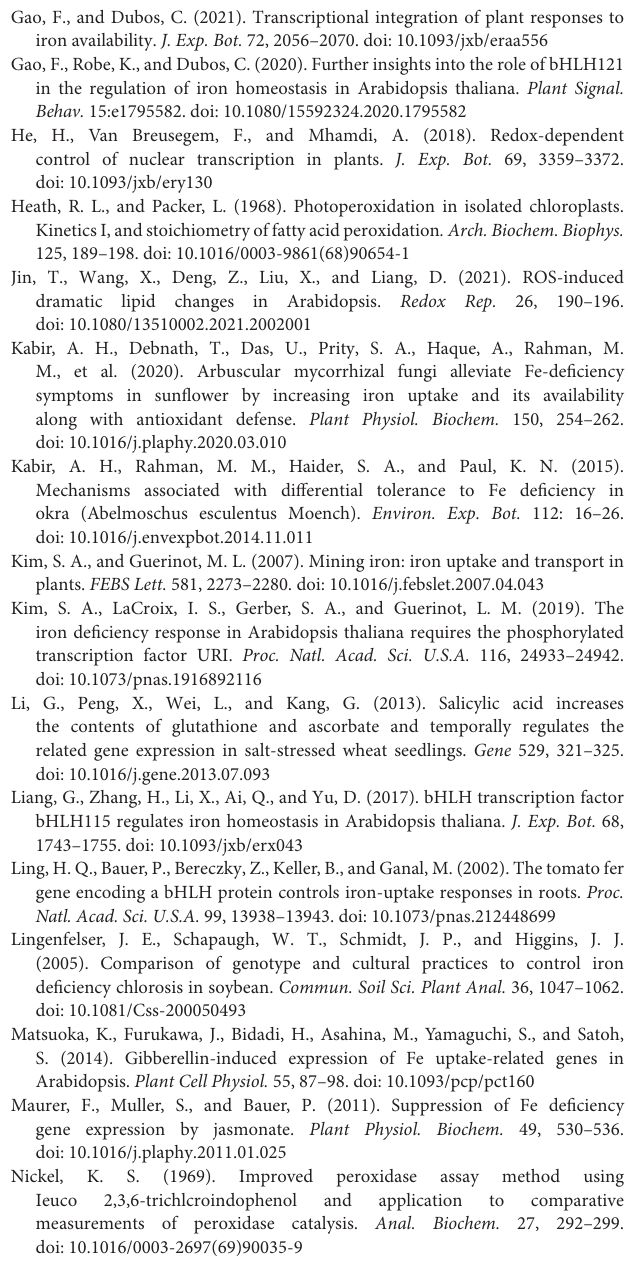
KEGG analysis between -Fe and E-Fe. E = P. liquidambaris inoculation. -Fe = 2 µ mol FeEDTA in Hogland nutrition. CK = 100 µ mol FeEDTA in Hogland nutrition. Supplementary Figure 8 | The qRT-PCR analysis of genes in the roots under Fe-sufficient or Fe-deficient conditions after P. liquidambaris colonization. The relative expression of each gene was calculated as the 2 − 11 CT value and normalized to the endogenous reference genes. Data and errors are mean ± SD, n = 6, and different letters indicate significant differences among treatments. p < 0.05. -Fe = 2 µ mol FeEDTA in Hogland nutrition. CK = 100 µ mol FeEDTA in Hogland nutrition. Supplementary Table 1 | Primers used for RT-qPCR